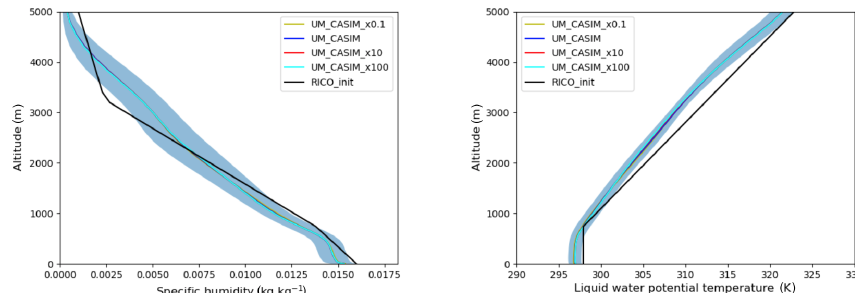
Figure 12. Average vertical profiles of liquid water potential temperature and specific humidity for each aerosol concentration, compared to the RICO initial setup as in Fig. 2, with the standard deviation of the baseline case shaded.